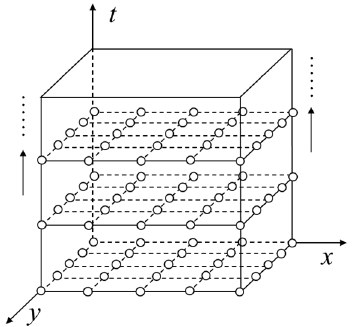
Table 4. The displacement at 8 time points of the center point of the four simply supported thin plate under the action of dynamic load q. Figure 11. Three-dimensional orthogonal mesh. Figure 11. Three-dimensional orthogonal mesh.